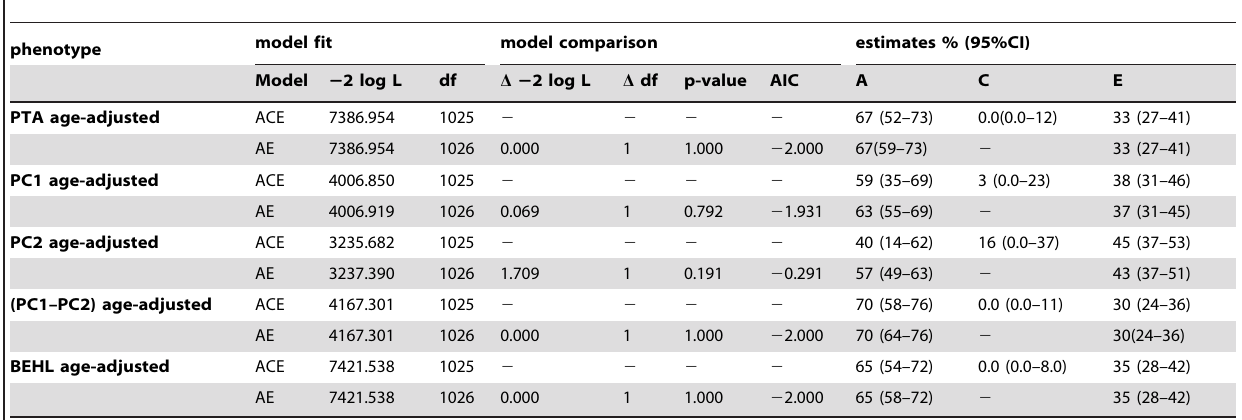
Table 4. Results of univariate variance modelling for age-adjusted pure-tone audiogram phenotypes.